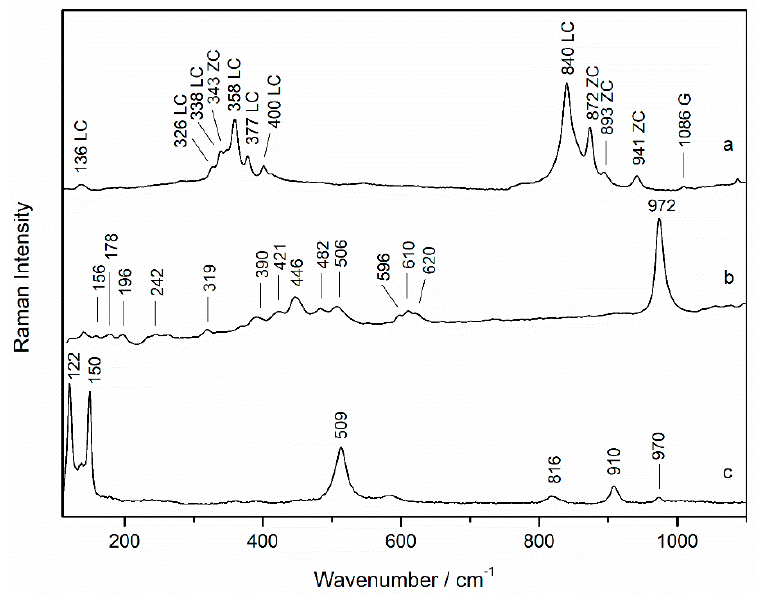
Figure 4. Raman spectra of ( a ) lead chromate (LC) in mixture with zinc chromate (ZC), ( b ) brochantite, and ( c ) atacamite (785 nm excitation laser) from a green area (sample wp2).